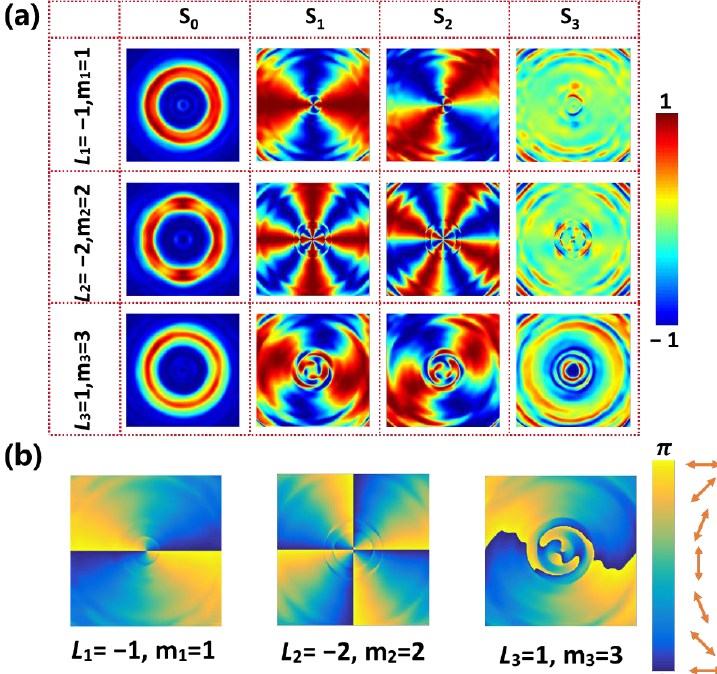
Figure 10. ( a ) The calculated normalized Stokes parameters correspond to point III in Figure 9a for three kinds of PPBs. ( b ) The calculated polarization orientations and distributions for three PPBs. Note that the orange double arrow represents the linear polarization orientation.